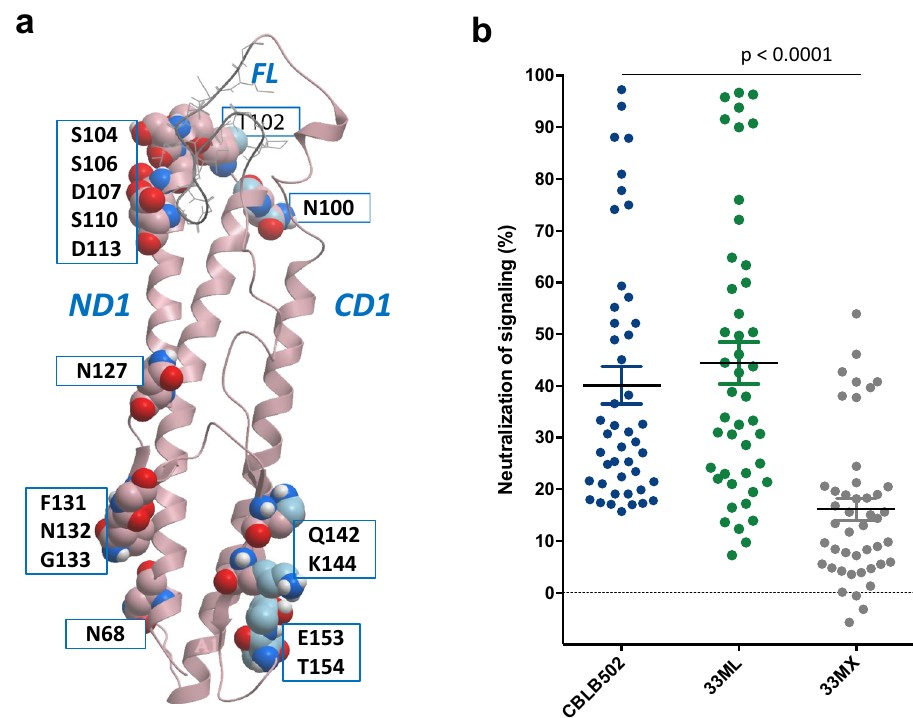
Fig. 3 Mapping and elimination of neutralizing B-cell epitopes in entolimod. a 3D model of the D1 domain of entolimod (from the available 3D structure of Salmonella fl agellin complexed with TLR5 (PDB:3V47 17 ), with amino acid residues identi fi ed as contributing to neutralizing B-cell epitopes and subjected to site-directed mutagenesis (replacement with alanine) in GP532 shown with spheres over the ribbon diagram ( n = 15). The potential glycosylation site at N127 that was replaced with alanine in GP532 is also shown. All of these modi fi cations are present in intermediate variant 33MX as well as GP532 (but not in entolimod or variant 33ML). b Side-by-side evaluation of entolimod (CBLB502) and two intermediate variants (33ML and 33MX) for inhibition of their signaling activity in HEK293-hTLR5::NF- κ B- lacZ reporter cells by 45 different human neutralizing antisera. Horizontal lines indicate the mean ± SD ( n = 45). P < 0.0001 for comparison of 33MX to either entolimod or 33ML (ANOVA test). Values below zero likely re fl ect the extent of assay variability.